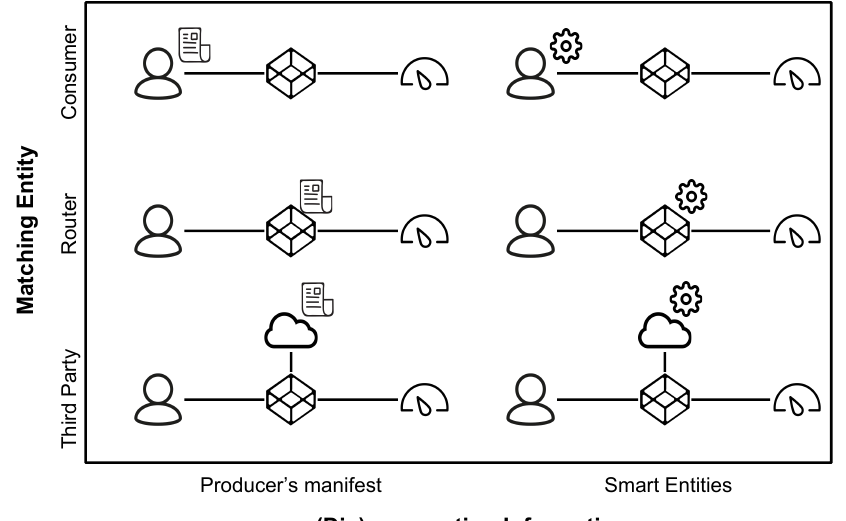
Figure 4. Dis(aggregation)